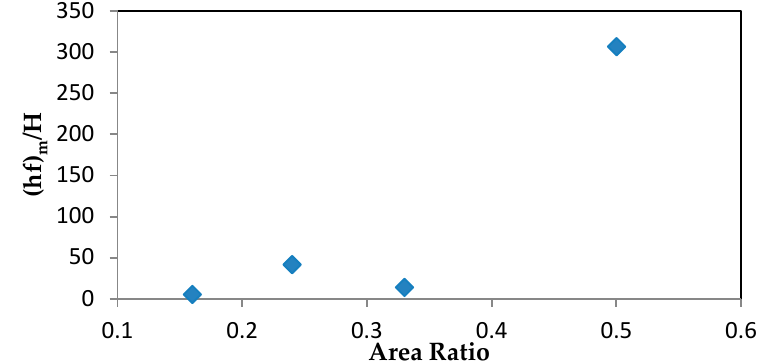
Figure 6. Variation of head loss with area ratio (inlet head = 2.2 m, spacing= 6.0 m).